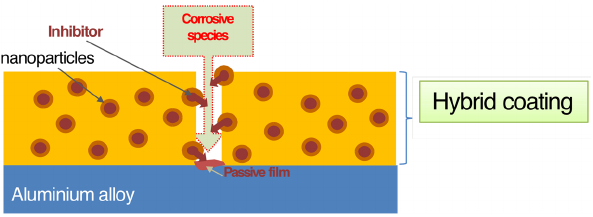
Figure 9. Generic scheme showing the corrosion healing mechanism of a hybrid sol ‐ gel coating containing inhibitor loaded nanoparticles [123].